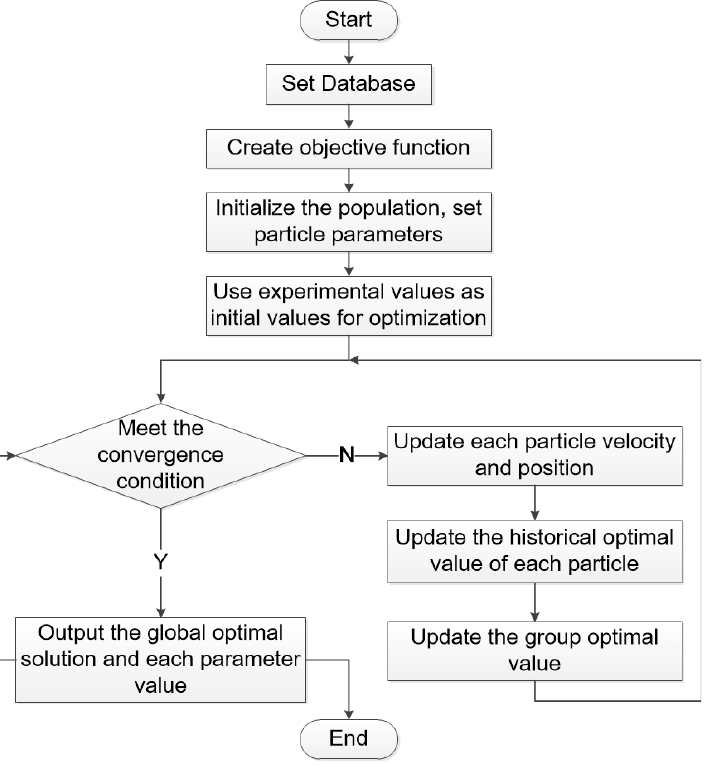
Figure 1. Process flowchart of the PSO algorithm. The quality of fitting between the predicted and experimental thermal degradation curves is evaluated via Equation (22) [41]: